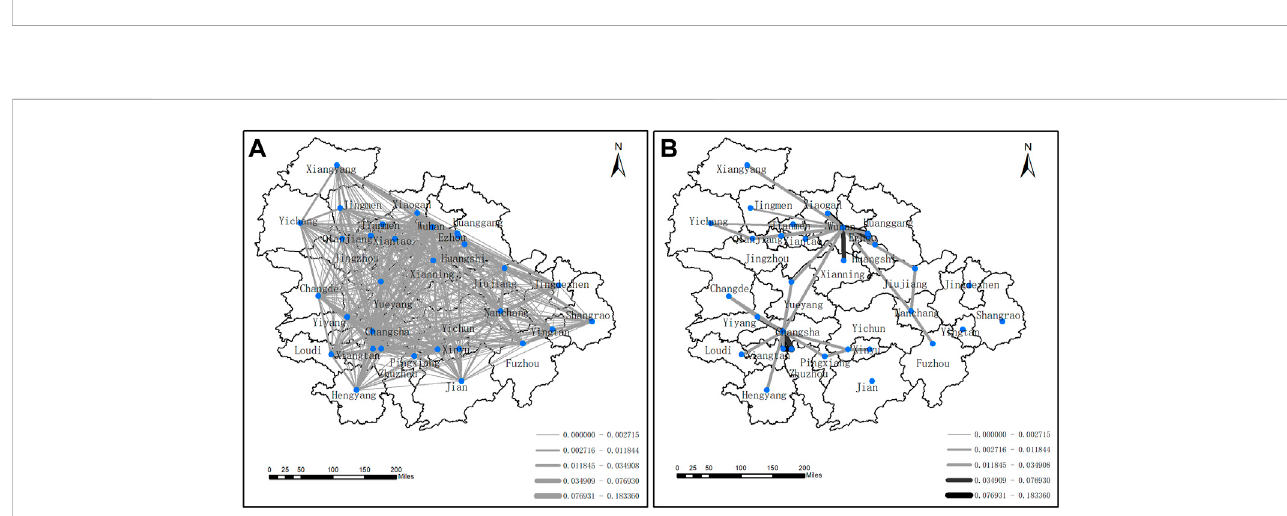
FIGURE 2 Intensity of economic ties in the middle reaches of the Yangtze River urban agglomeration in 2020 (A,B) .